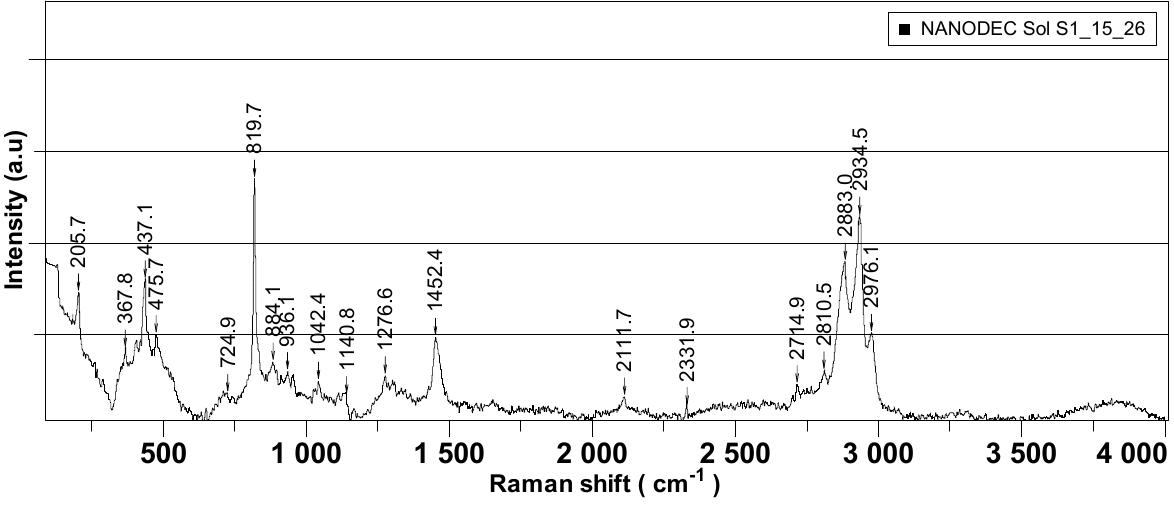
Figure 6. RAMAN spectra of the neat organic decontamination solution. Table 2. Control ‡ of initial contamination level of the tested